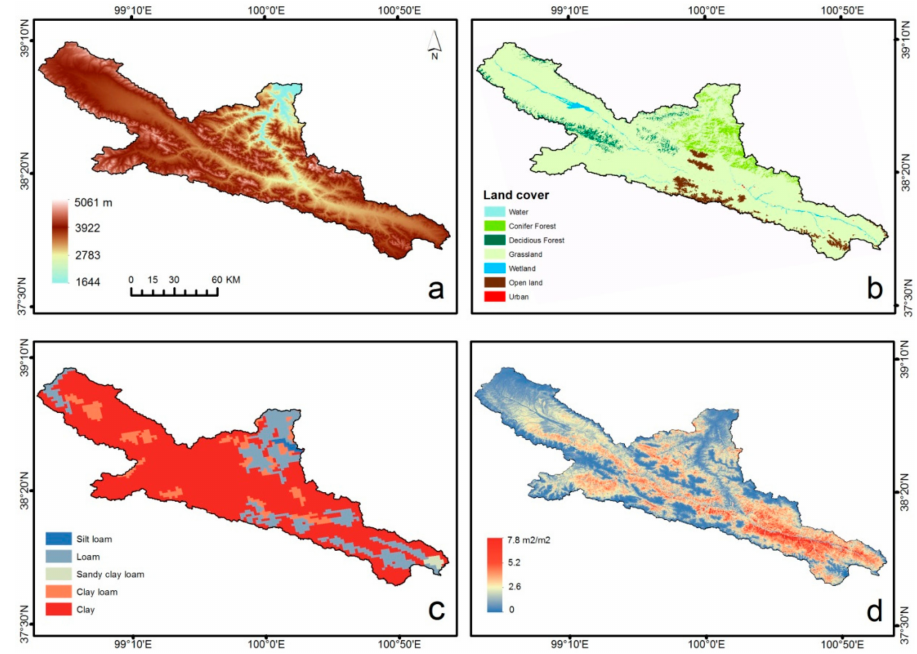
Figure 3. Main spatial dataset of the Upper Heihe watershed prepared for model input: ( a ) digital elevation model (DEM), ( b ) land cover, ( c ) soil texture, and ( d ) maximum leaf area index